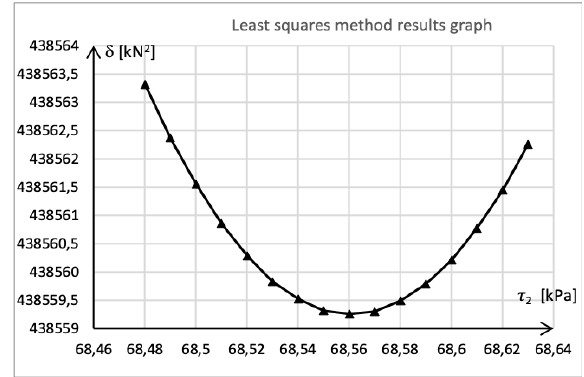
Figure 7b: Relationship between settlement and shear stress at the base of Pile 1.